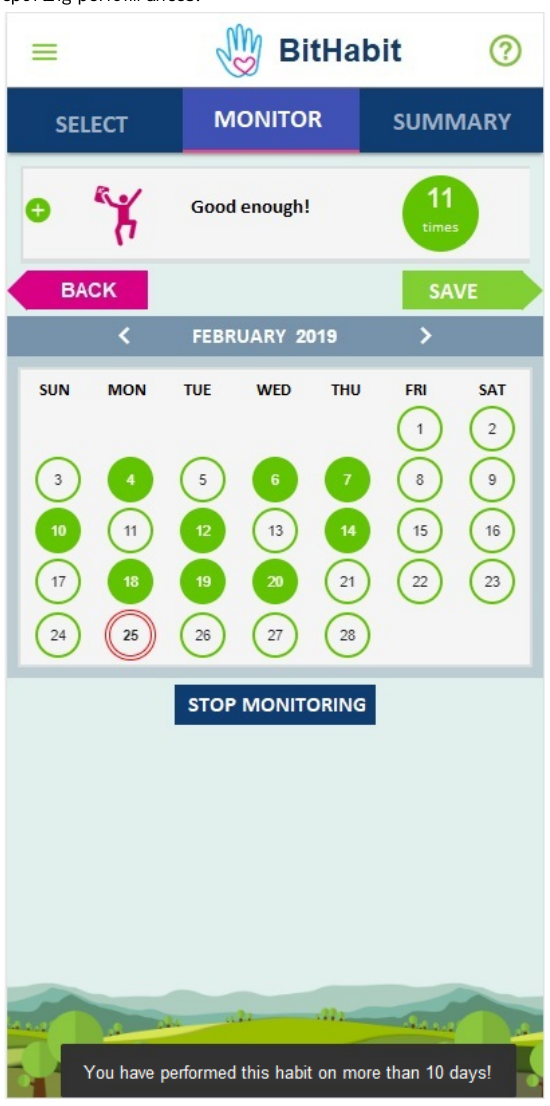
Figure 2. Calendar-functionality enables reporting